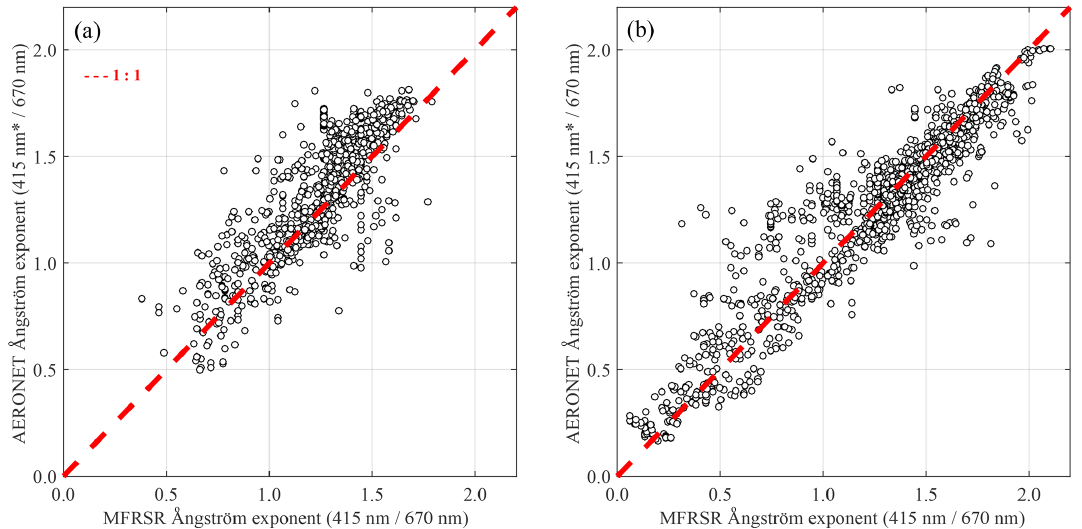
Figure 7. The Ångström exponent (AE) for the visible spectrum derived using AOD at 415 and 670nm from the on-site calibrated MFRSR as a function of AE derived from AOD at 415nm ∗ and 670nm corresponding to the AERONET direct Sun product level 2.0 for (a) 2012 and (b) 2015. The asterisk ( ∗ ) indicates that AERONET AOD at 415nm was estimated using AE since this channel is not present in network Sun photometers. The red dashed line represents 1 : 1